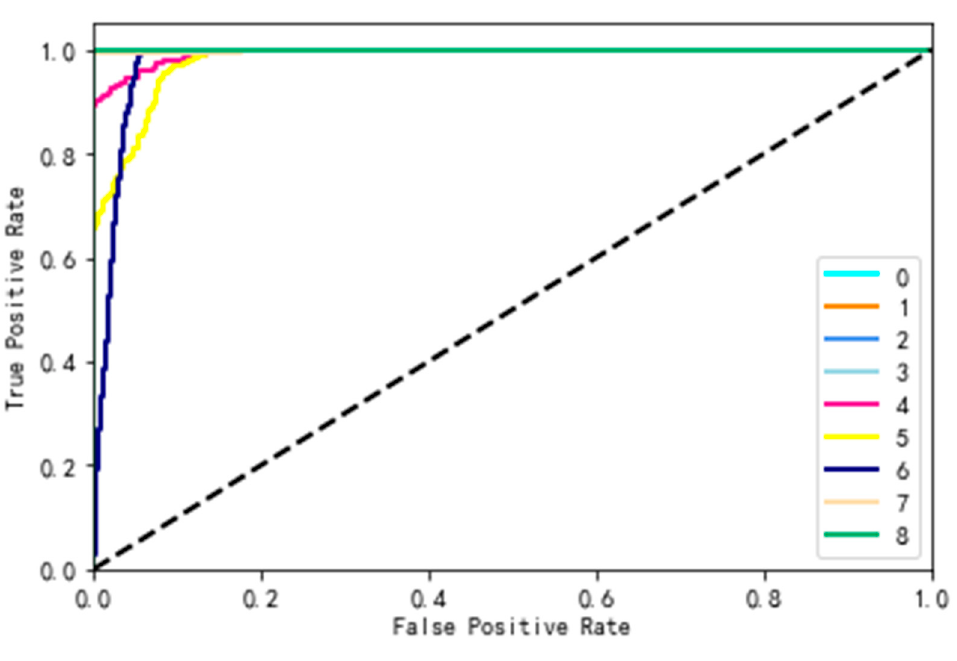
Figure 13. Tower_of_London receiver operating characteristic curve.